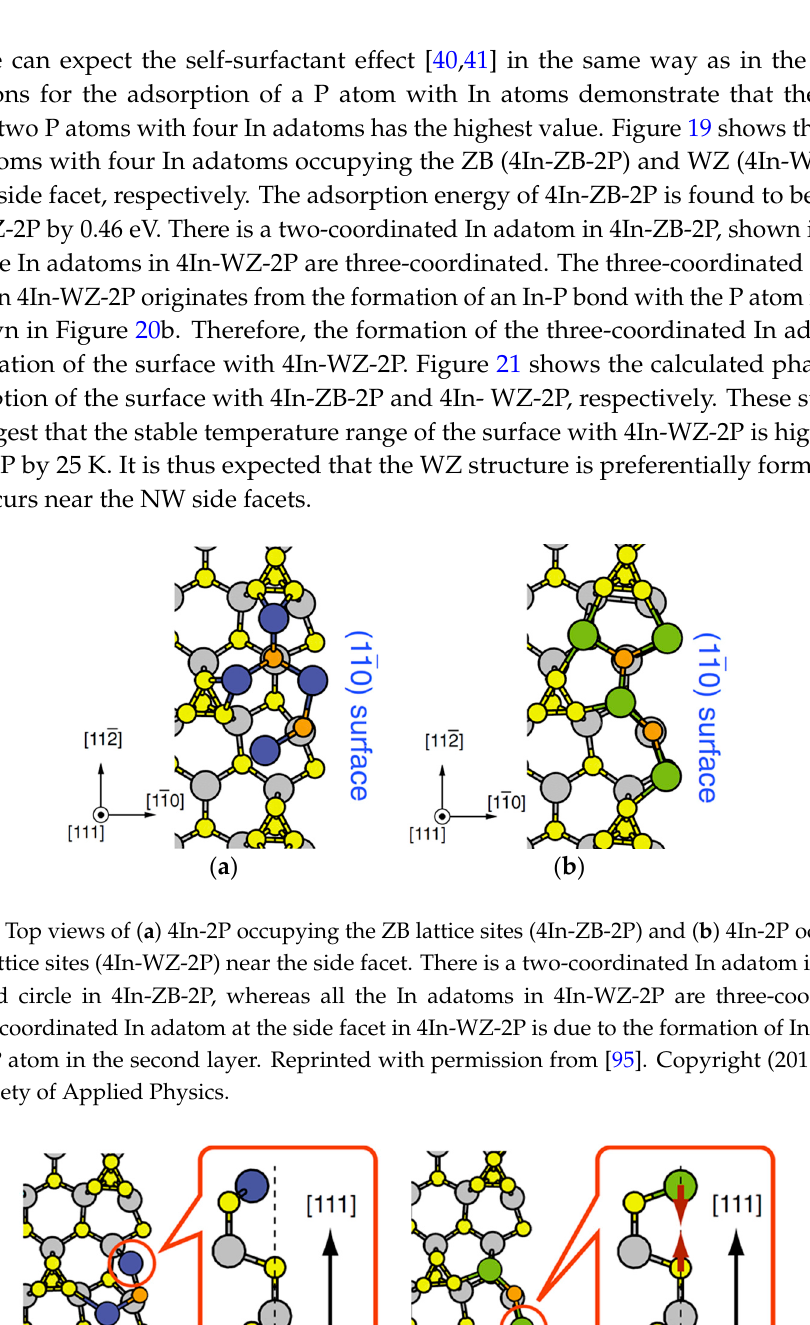
( a ) ( b ) Figure 21. Calculated phase diagrams of ( a ) 4In-ZB-2P and ( b ) 4In-WZ-2P adsorbed surfaces as functions of temperature and P 2 pressure. In pressure is taken to be 3.3 × 10 (cid:2879)(cid:2871) Torr. Colored regions correspond to the atom-adsorbed regions. Reprinted with permission from [95]. Copyright (2011) by the Japan Society of Applied Physics. To determine the predominant area for the nucleation, we estimate the difference in adsorption probability between the central and side areas. By comparing the phase diagram shown in Figure 18 with that in Figure 21b, it is concluded that the difference in the adsorption probability between the central and side areas to be negligible, so that adsorption occurs in both the central and side areas.